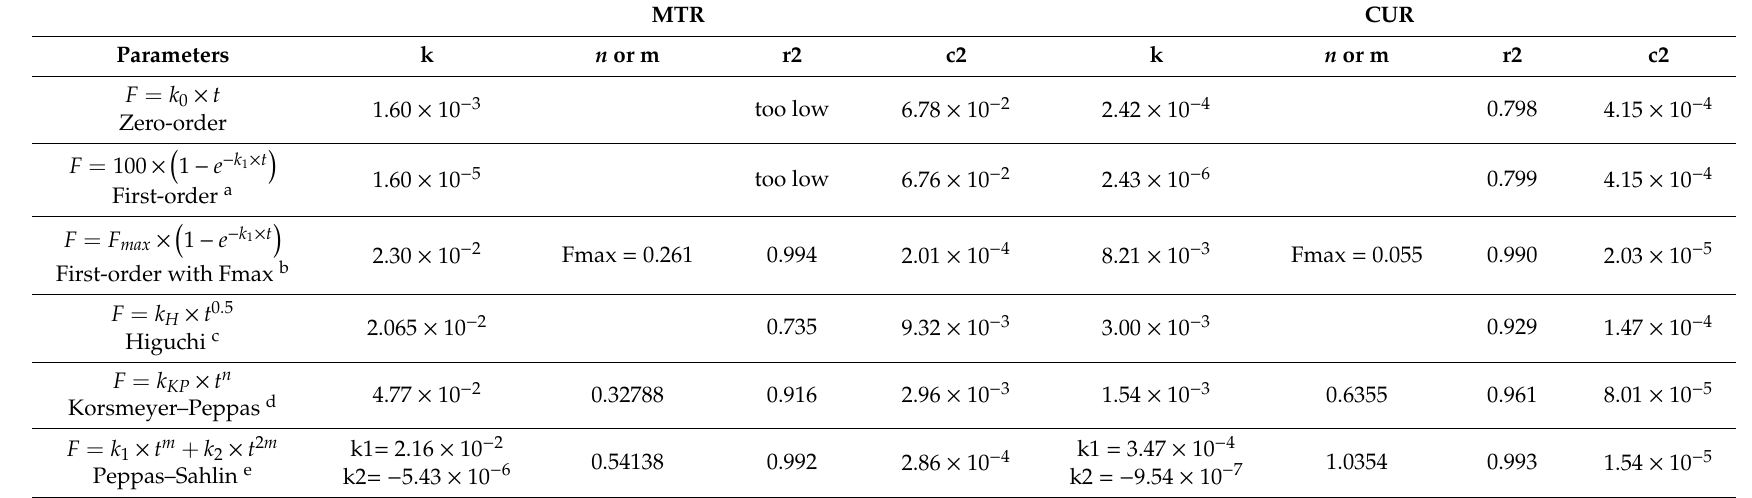
Table 5. Analysis of kinetic model parameters values for MTR and CUR released from